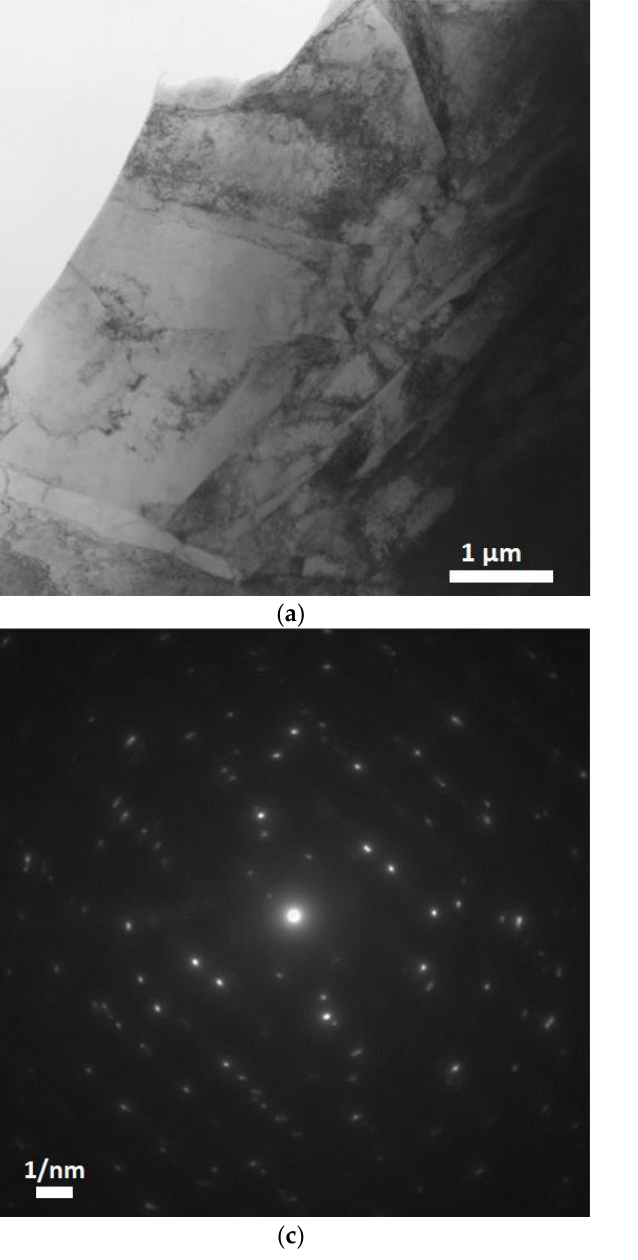
Figure 11. Fine structure of material of products obtained by wire-feed electron beam additive manufacturing right at the substrate (in the interlayer). Bright-field ( a , b ) TEM images, SAED ( c ) and its identification scheme ( d ).